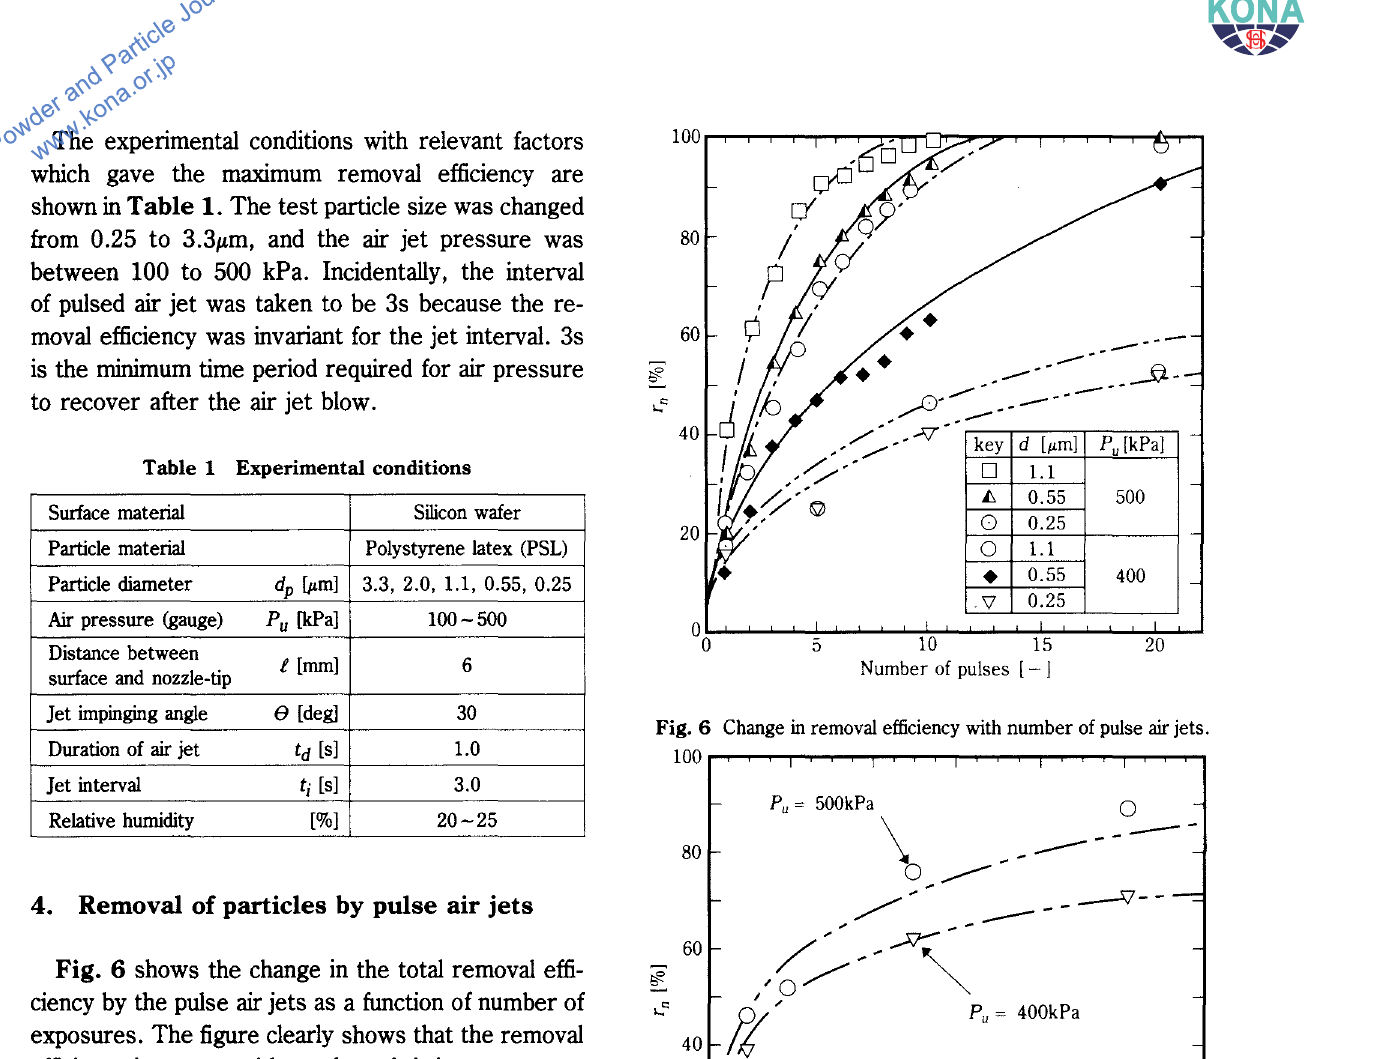
Fig. 6 Change in removal efficiency with number of pulse air jets.